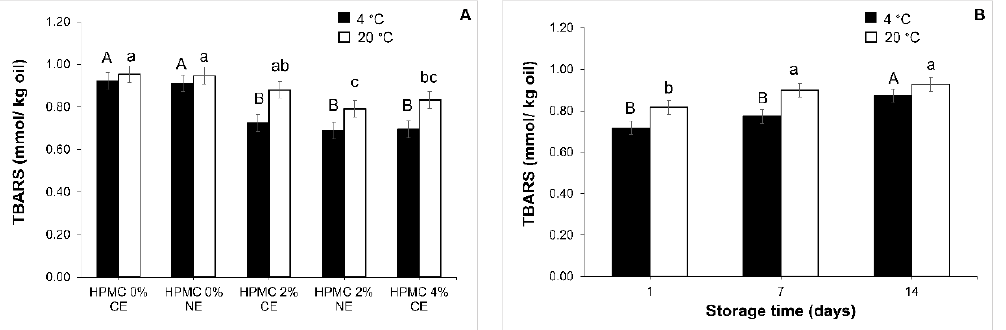
Figure 8. Mean values and 95% HSD confidence intervals. ( A ): TBARS mean values according to the type of in emulsions at 4 °C (filled bars) and 20 °C (empty bars), conventional emulsions (CE-) and nanoemulsion (NE-) stabilised with lecithin and HPMC (0, 2 and 4%); ( B ): TBARS mean values according to the storage day at 4 °C and 20 °C. Different capital letters indicate significant differences in the mean at 4 °C and different lower-case letters indicate significant differences in the mean at 20 °C ( p < 0.05).